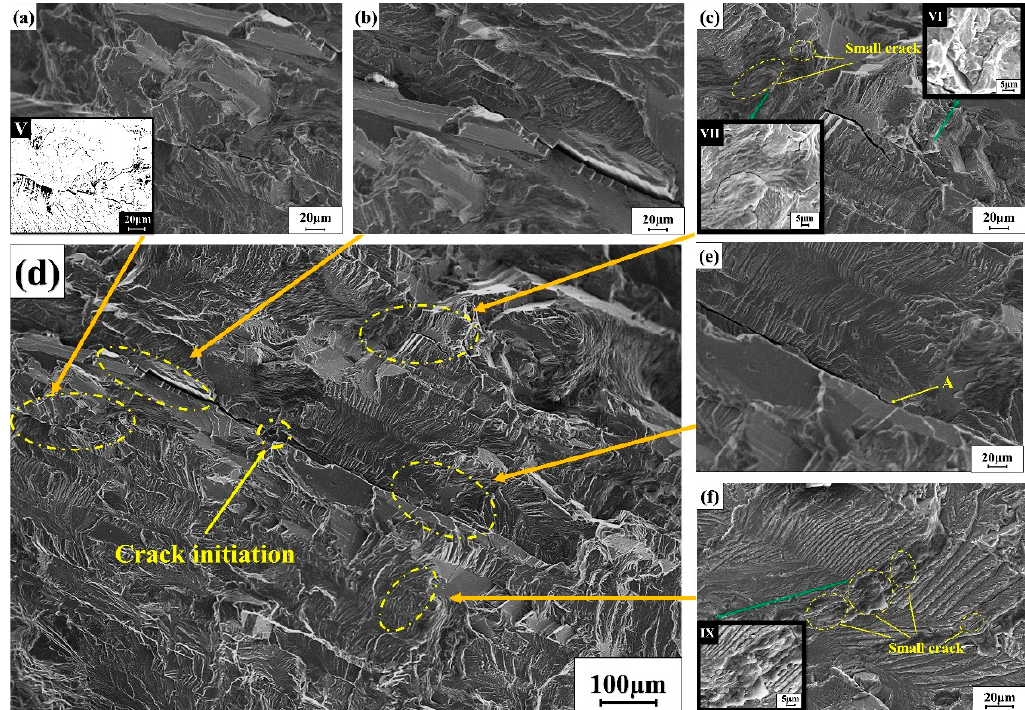
Figure 9. ( a ) Enlarged view 1 of small cracks near the main crack; ( b ) Enlarged view 1 of the main crack; ( c ) Enlarged view 2 of the small cracks near the main crack; ( d ) Microscopic morphology of the main crack; ( e ) Partial enlarged view of the main crack; ( f ) enlarged view 2 of the fatigue band near the main crack.; V is a special processing ( a ); VI, VII, IX were the enlarged area of the green arrow.